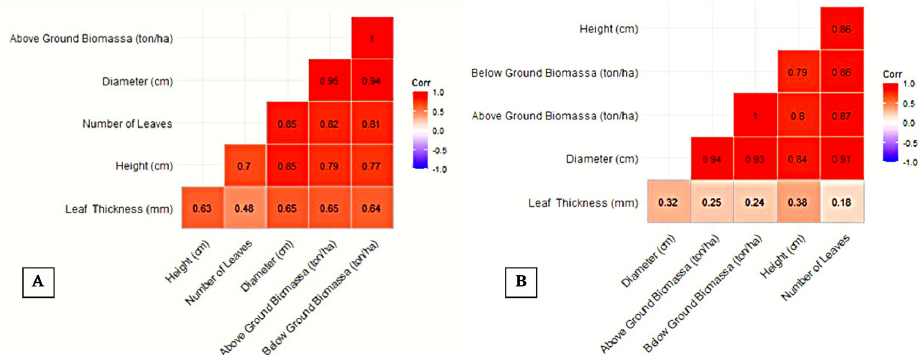
Figure 6. Relationships between height, diameter, above-ground biomass, underground biomass, number of leaves, and leaf thickness. ( A ) Planting with propagules; ( B ) planting with seedlings (the increasing intensity of the red color in the diagram indicates that the correlation was higher).